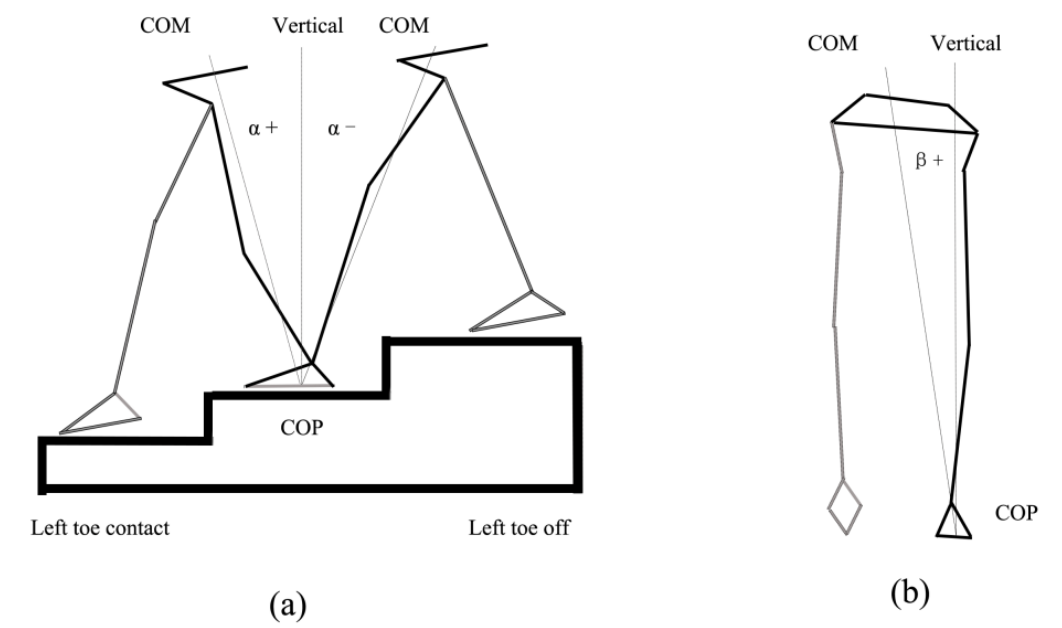
Figure 1. ( a ) Graphical representation of the right foot single-support phase beginning with the left toe-off the fourth step of the staircase and ending with the left foot contacting the second step, also showing the anterior / posterior center of mass (COM)–center of pressure (COP) inclination angle α . ( b ) The medial / lateral COM–COP inclination angle β .